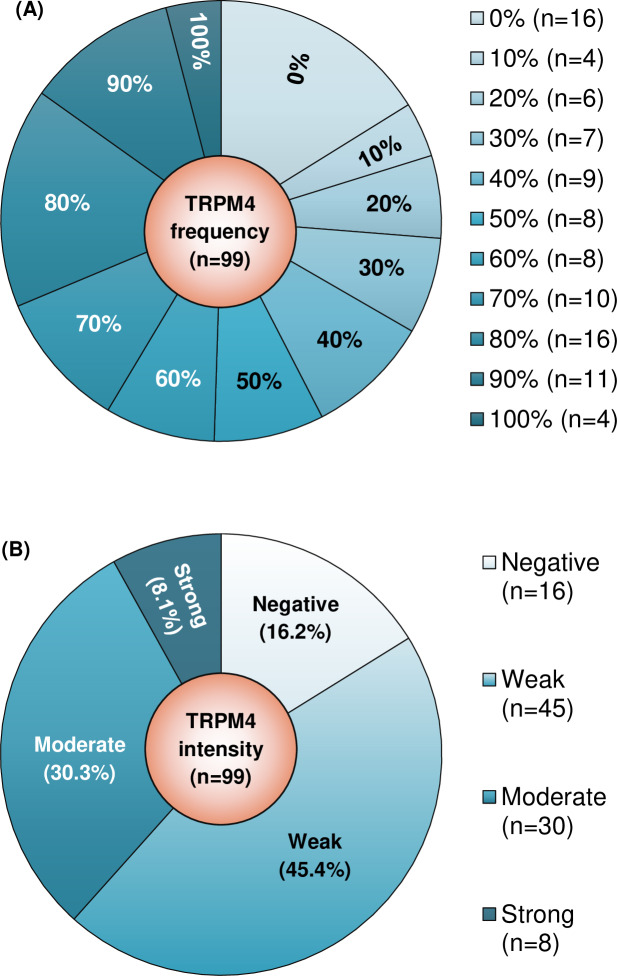
TRPM4 protein expression profile in breast cancer cases in terms of TRPM4 frequency and intensity.(A) Distribution of breast cancer cases (n = 99) according to TRPM4 frequency at every 10% increment. (B) Distribution of breast cancer cases (n = 99) according to TRPM4 intensity (weak, moderate or strong) and the proportion of cases for each intensity.